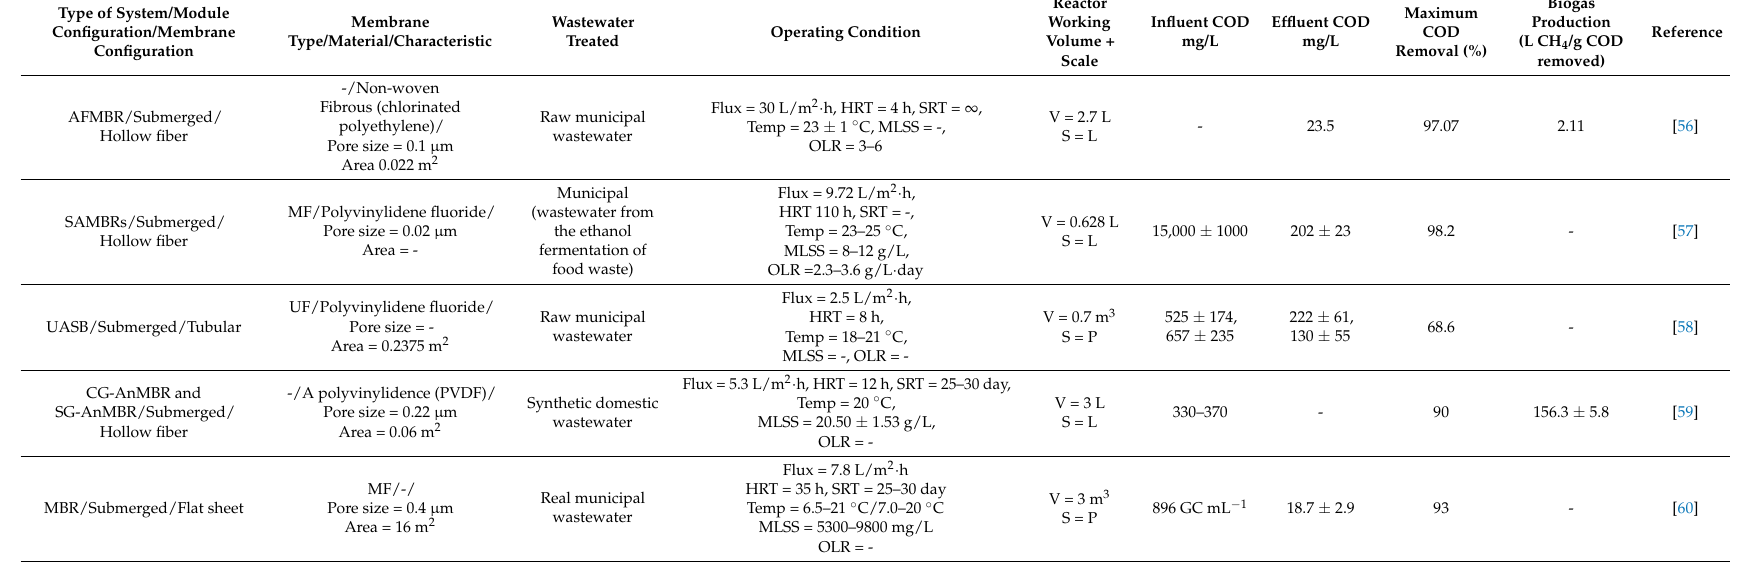
Table 3. References on anaerobic membrane bioreactors (AnMBRs) for municipal wastewater